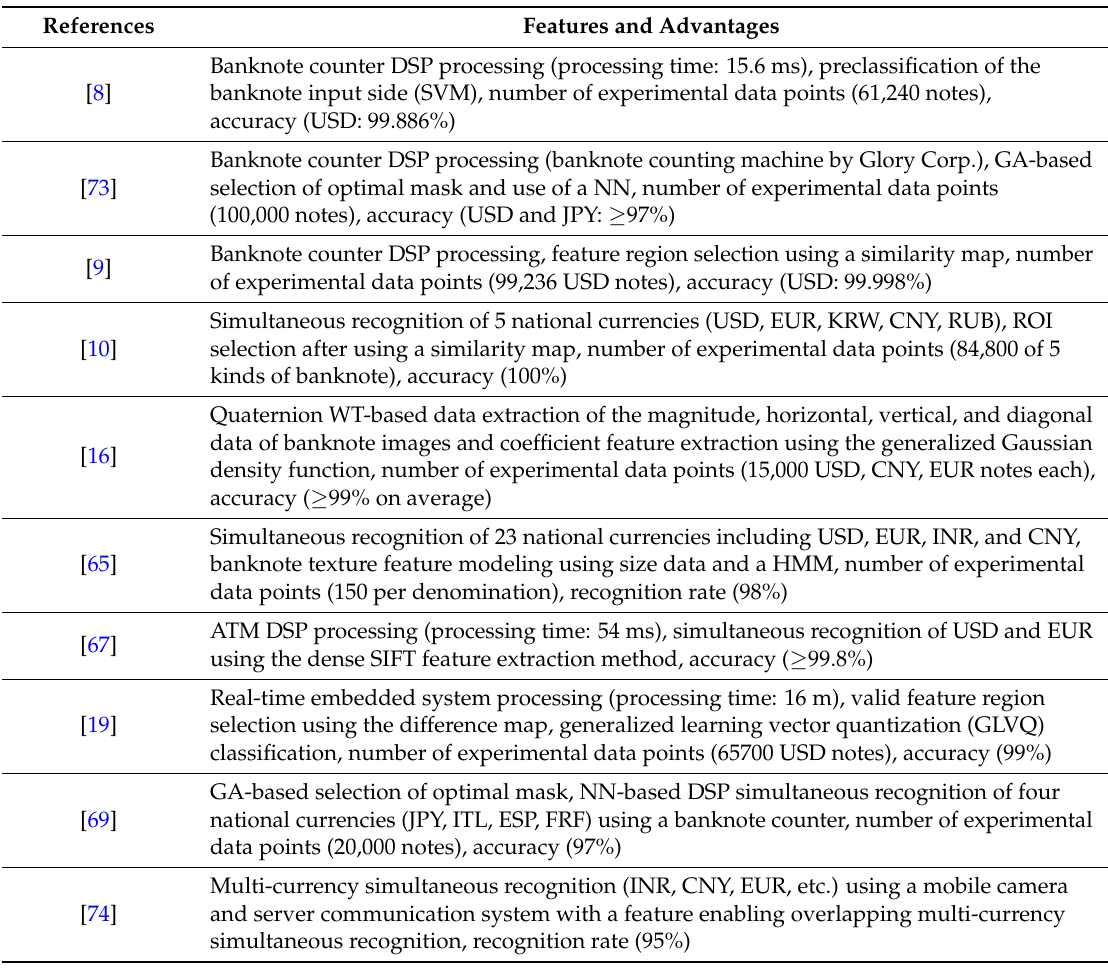
Table 5. Feature and advantage analyses of existing banknote recognition methods (DSP processing, high-capacity DB, multi-currency simultaneous